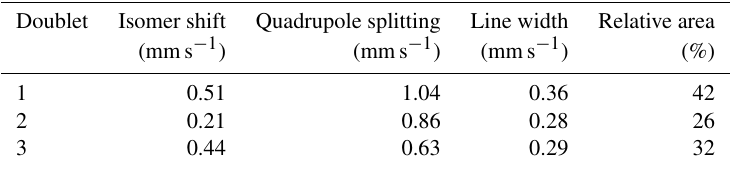
Table 2. Parameters of the Mössbauer spectrum of beraunite (NM sample). Doublet Isomer shift Quadrupole splitting Line width Relative